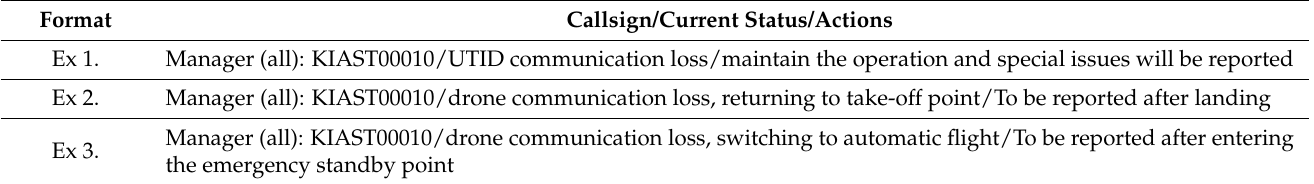
Table 6. Format and examples of